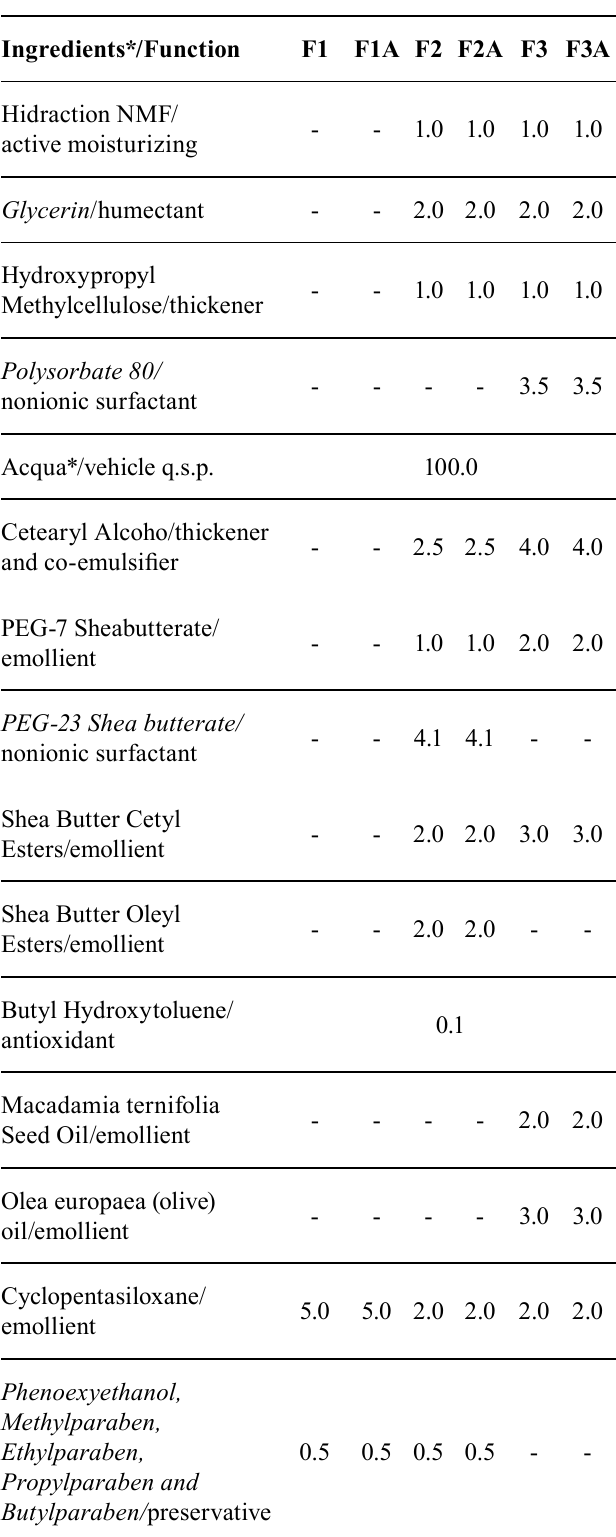
TABLE I – Q ualitative and quantitative composition (% w/w) of the